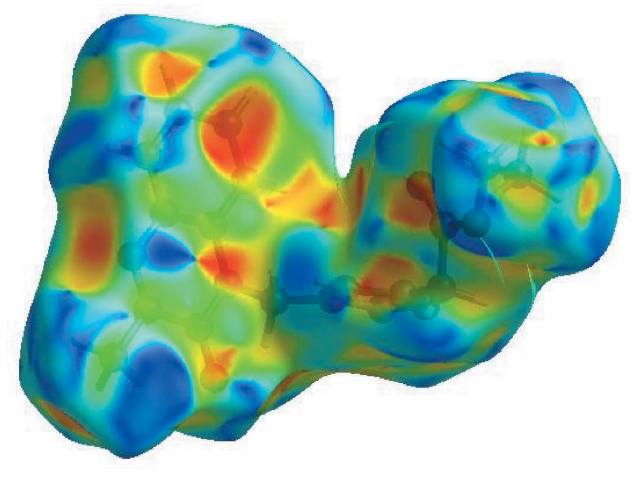
Figure 6 Hirshfeld surface of the title compound plotted over